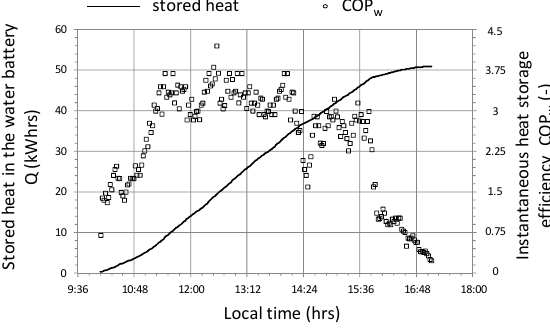
Figure 25. Changes in the efficiency of heat storage and the amount of heat stored in cycle No. 3.